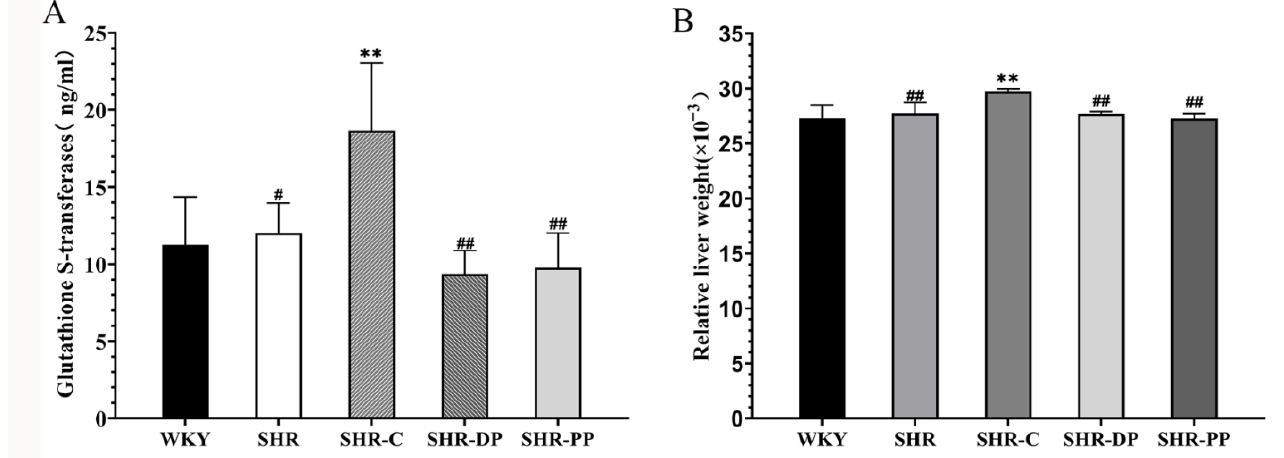
Figure 6. The influence of liver of rats in each group after pea peptide and double peptides inter- vention. ( A ) Serum concentration of GST; ( B ) The relative organ weight of liver. The data in the figure are expressed as mean ± SEM. ** p < 0.01, represents the difference from the WKY group, respectively; # p < 0.05, ## p < 0.01, represents the difference from the SHR group, respectively.